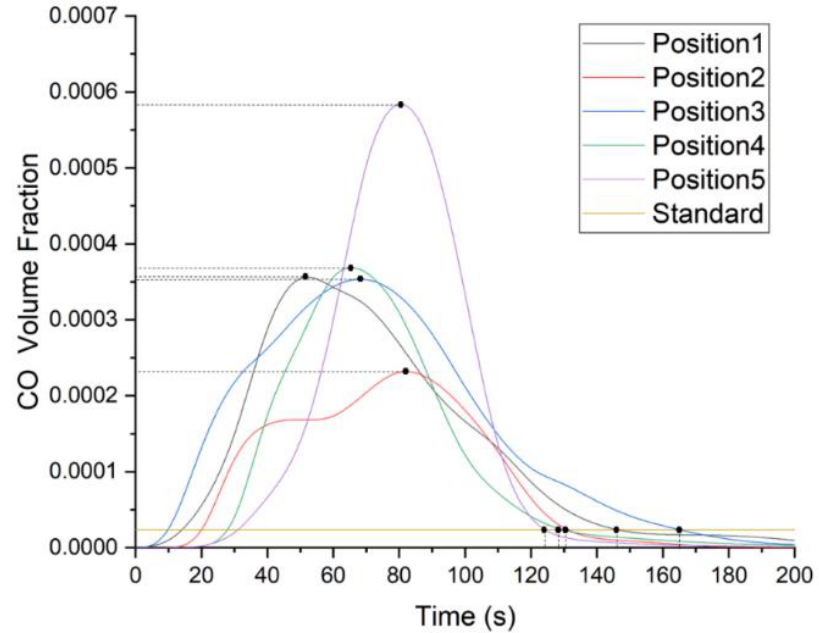
Figure 7. Blasting fumes from work face 1.